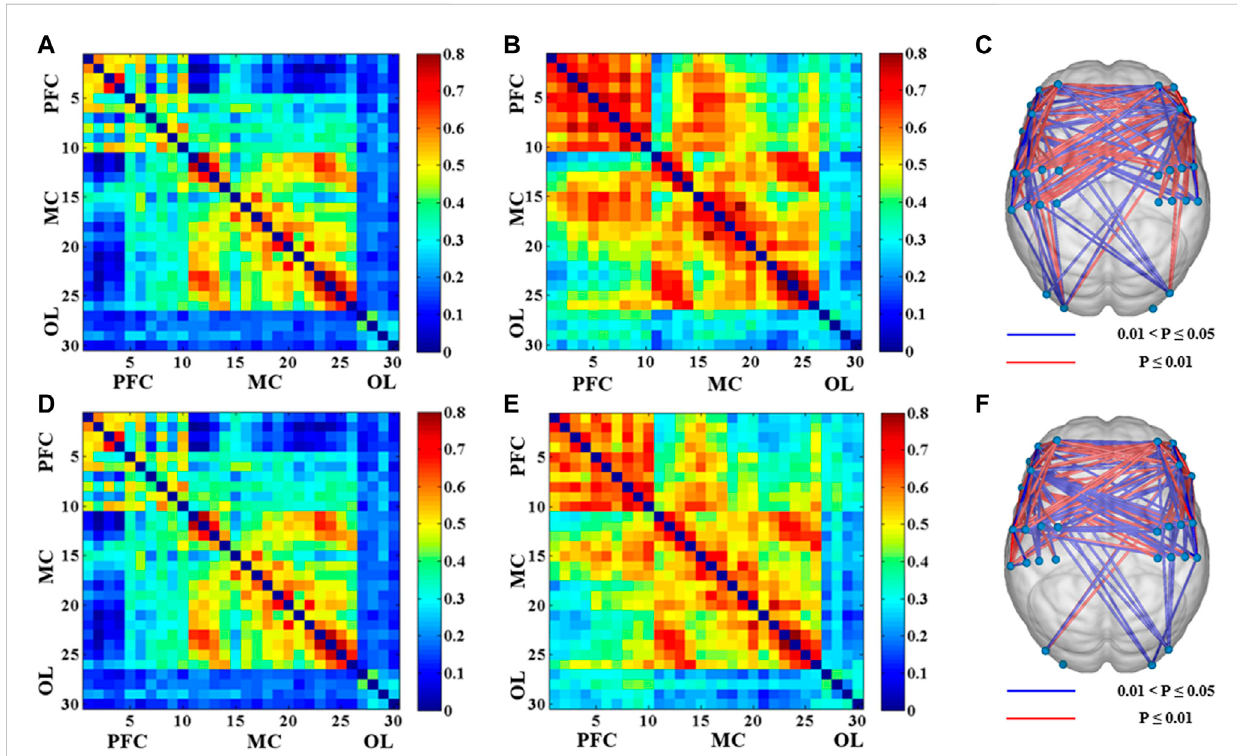
FIGURE 2 The results of the functional connectivity between 30 channels in different conditions ( p < 0.05). (A) Correlation matrix between 30 channels under 20% MVC of the dominant side. (B) Correlation matrix between 30 channels under 80% MVC of the dominant side. (C) The signi fi cant difference of functional connectivity of the 80% MVC relative to the 20% MVC between 30 channels under the dominant side. (D) Correlation matrix between 30 channels under 20% MVC of the non-dominant side. (E) Correlation matrix between 30 channels under 80% MVC of the non-dominant side. (F) The signi fi cant difference of functional connectivity of the 80% MVC relative to the 20% MVC between 30 channels under the non-dominant